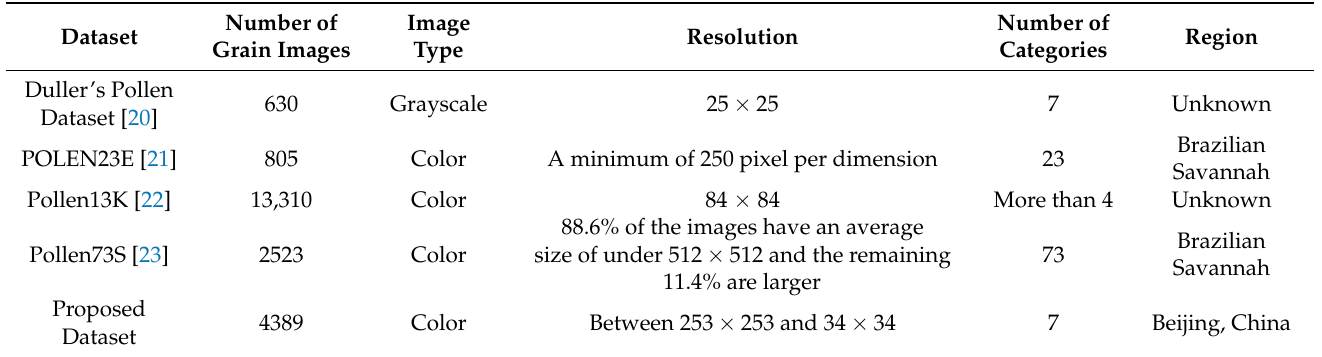
Table 1. The comparison between the proposed dataset and the main datasets that are used for the pollen image classification